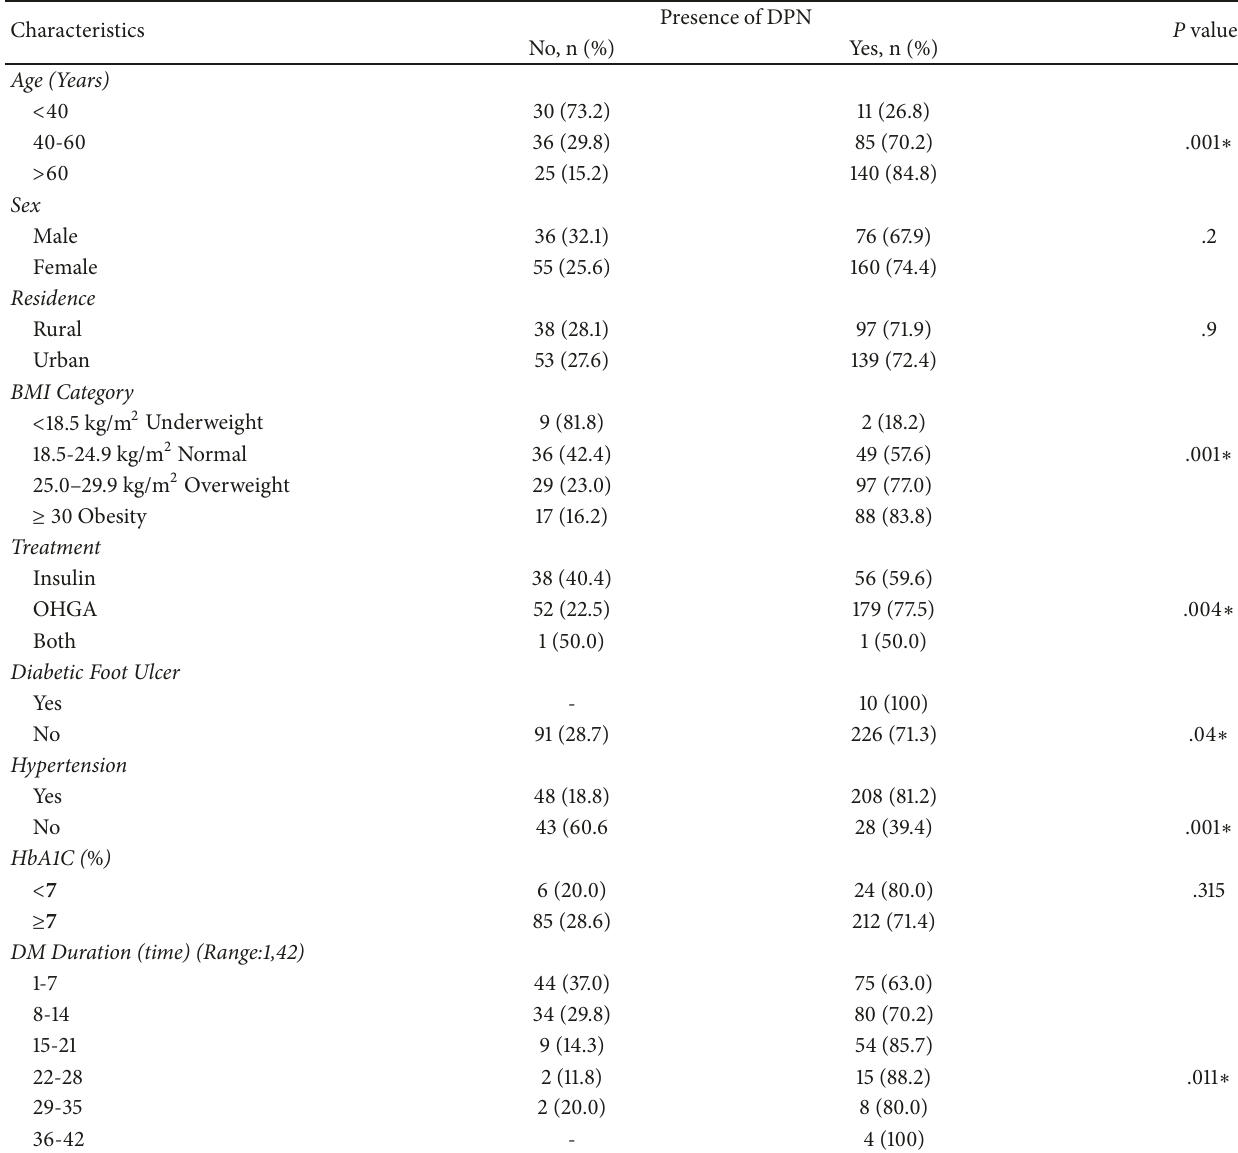
Table 3: Prevalence of peripheral neuropathy by independent variables